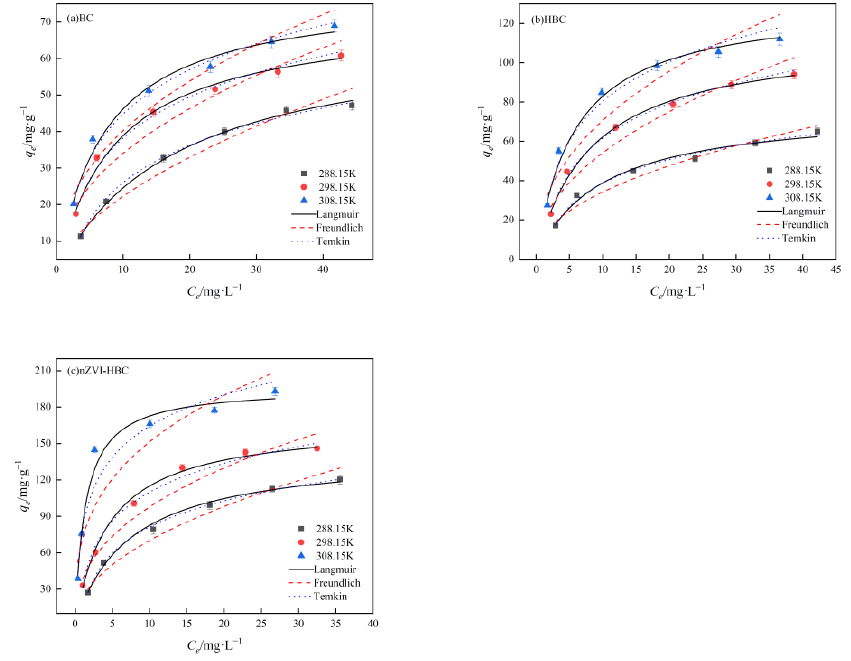
Figure 10. Adsorption isotherms of OTC with ( a ) BC, ( b ) HBC, and ( c ) nZVI-HBC. Table 1. Adsorption isothermal equation fitting parameters of OTC adsorption of BC, HBC, and